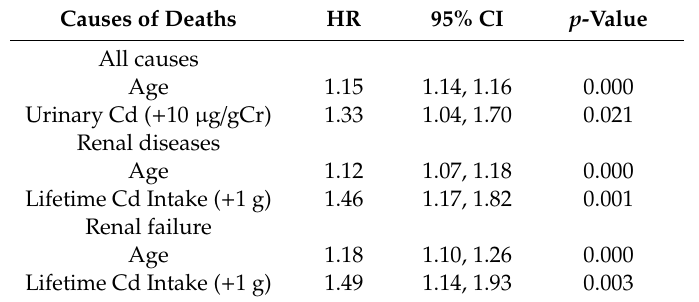
Table 4. Dose–response relationships between hazard ratios and Cd exposure markers in women. Causes of Deaths HR 95% CI p -Value All causes Age 1.15 1.14, 1.16 0.000 Urinary Cd ( + 10 µ g /